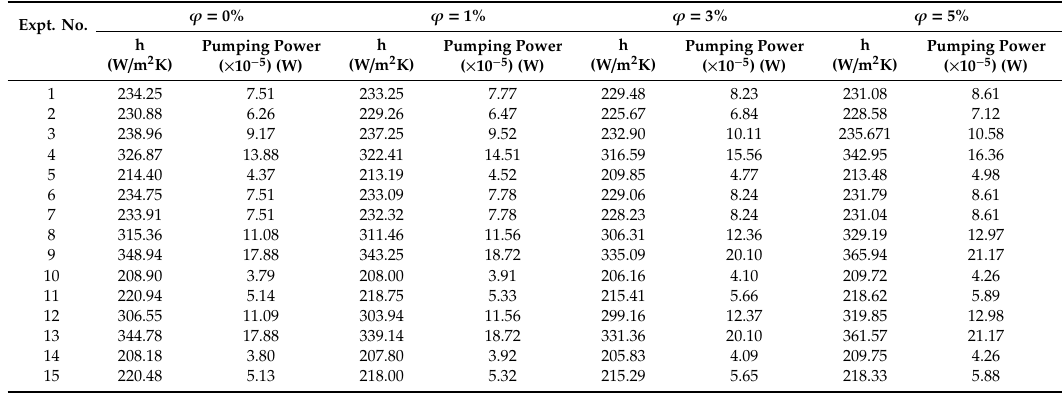
Table 7. Response values.